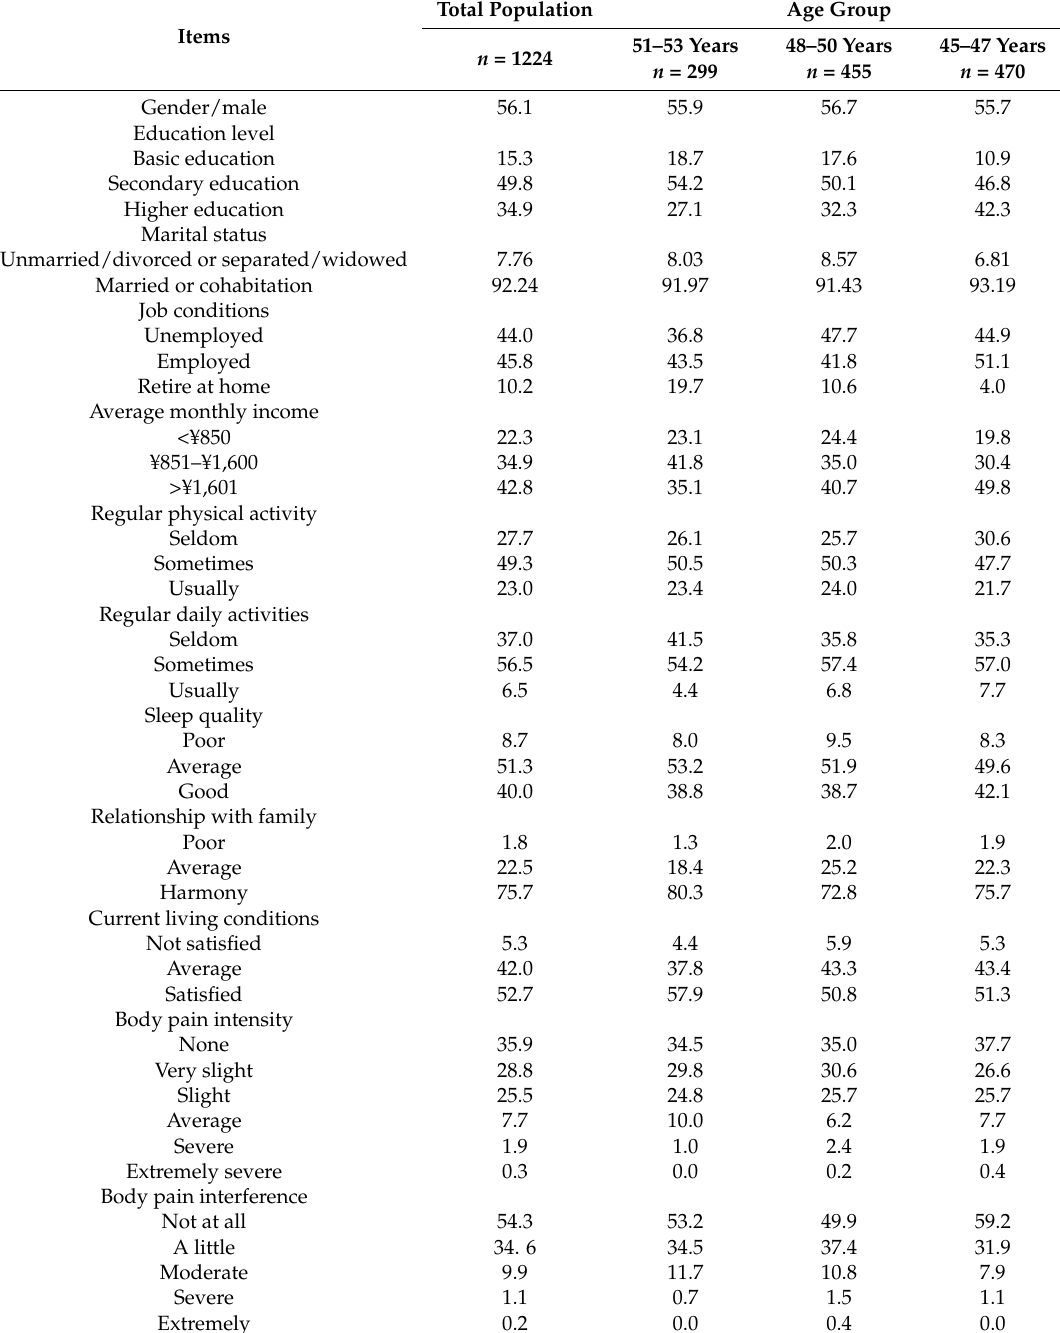
Table 1. Characteristics of the study participants according to age group in adults (45–53 years old) in Chongqing, China ( n = 1224,